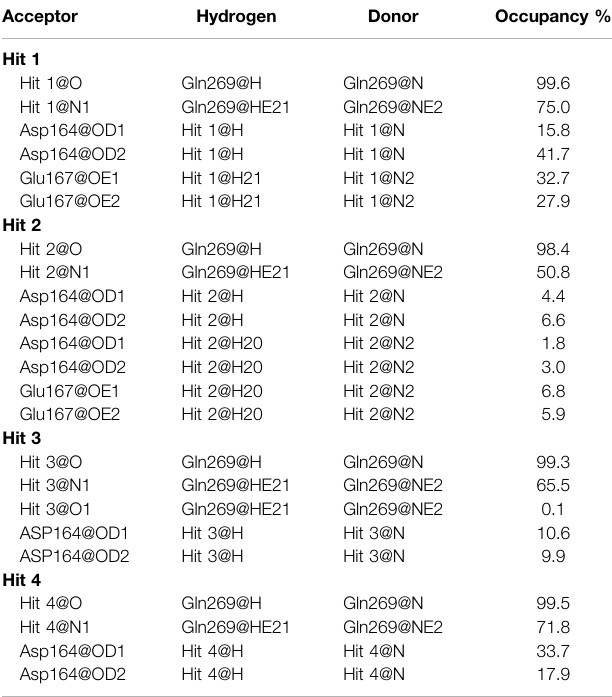
TABLE 3 | Hydrogen bond and its occupancy formed in the binding of each hit and PLpro during the MD simulation. Acceptor